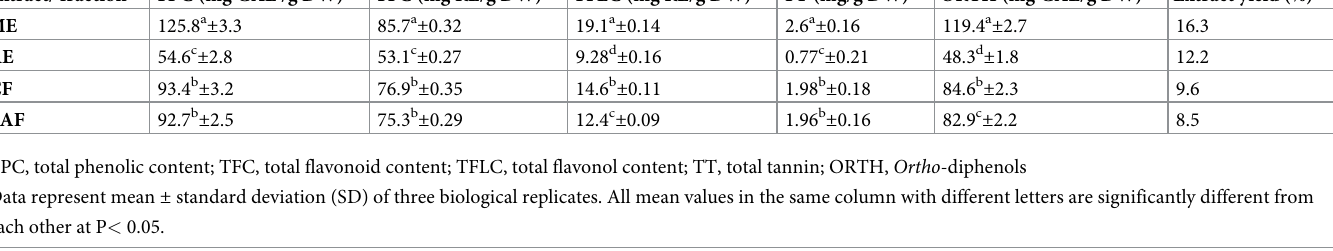
Table 2. Total phenolic, flavonoid, flavonol, tannin and ortho -diphenol contents in J . mimosifolia leaf extracts and fractions. Extract/ fraction